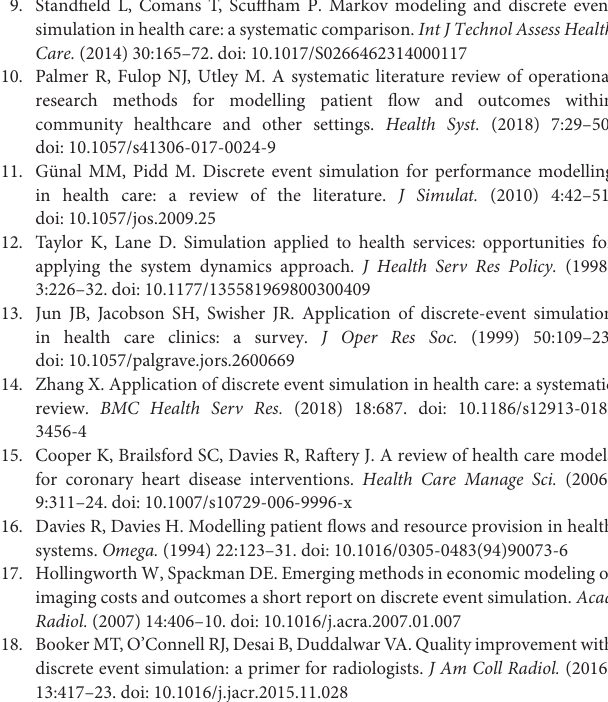
Supplementary Figure | Increasing ECR patient volume on service bottleneck. Standardized density of patients in queue: the probability density of patients who are waiting standardized to patients who are not waiting. (A) Baseline scenario. (B) Doubling ECR patients in baseline scenario. (C) Tripping ECR patients in baseline